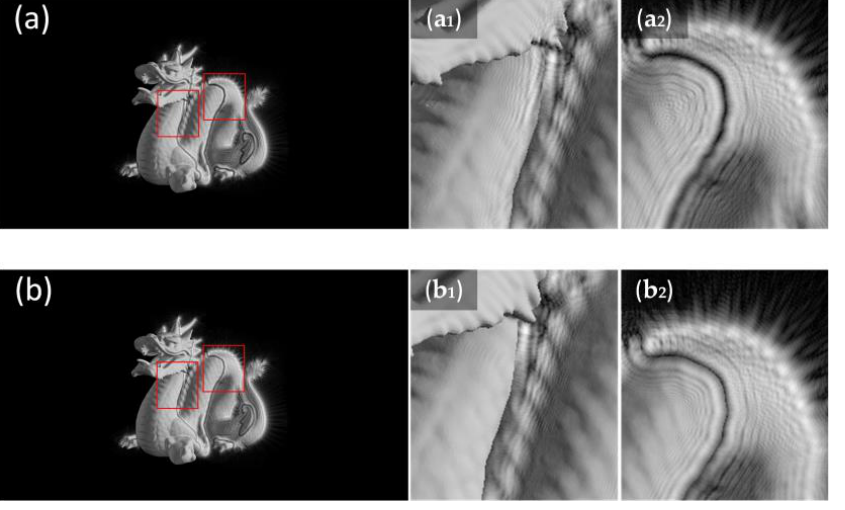
Figure 5. ( a , b ) are the results after the wave propagation without the mask and with the mask when Δz is 10 mm. ( a 1 , b 1 ) and ( a 2 , b 2 ) are the details of ( a , b ) in the red box region, respectively. After obtaining the first target plane and the sec o nd target plane, we use the SGD method with weighted complex loss function to update the initial phase and obtain high- quality holographic reconstructed images. Because the amplitude loss part of the focus region is used in the whole loss function, the focus regions of the reconstructed images acquire more attention than the defocus regions and obtain higher quality. The comparisons of the reconstructed results between the SGD method with complex loss function and the proposed method when z r = 230 mm and ∆ z is 30 mm are shown in Figure 6. The interference between the focus regions and the defocus regions of the proposed method is slighter than that of the SGD method with complex loss function.